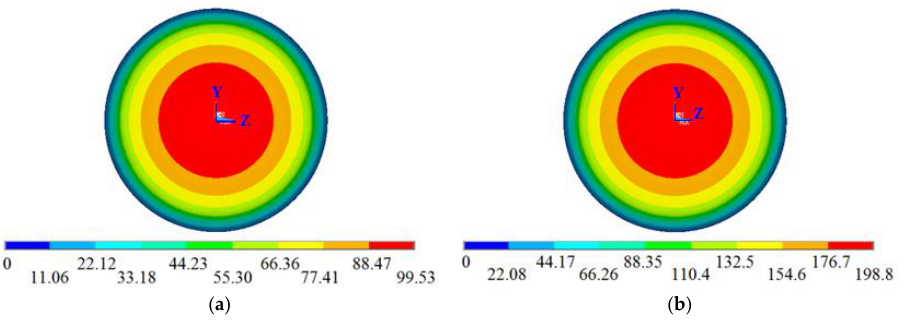
Figure 6. Temperature field distribution at different c ρ : ( a ) 1800; ( b ) 900. Table 3. Effect of material density and specific heat on stagnation temperature 1 .